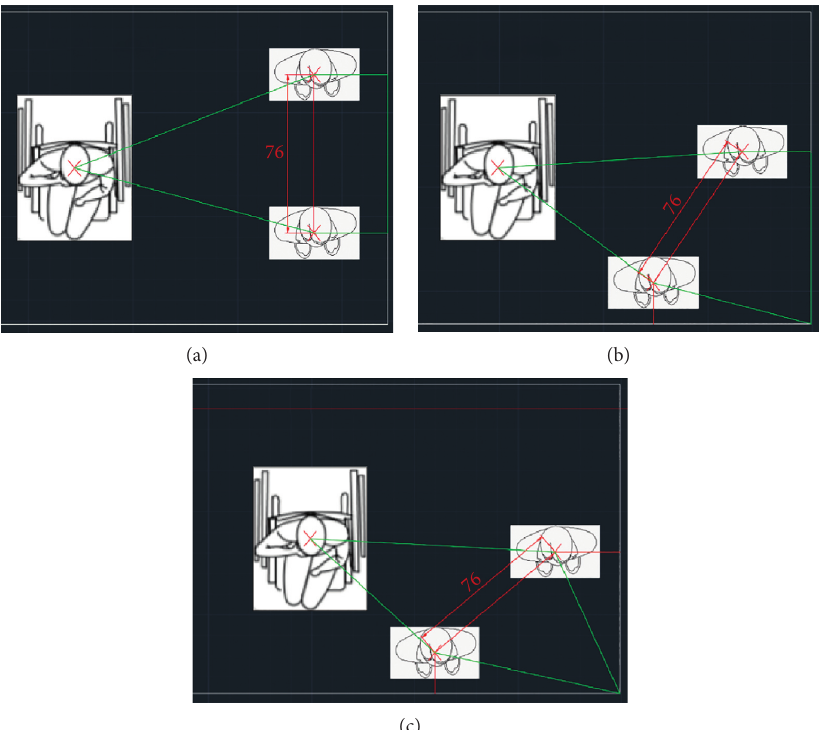
Figure 6: Preferential waiting area as a boundary of the space occupied by a wheelchair-bound. (a) Condition 1. (b) Condition 2. (c) Condition 3.